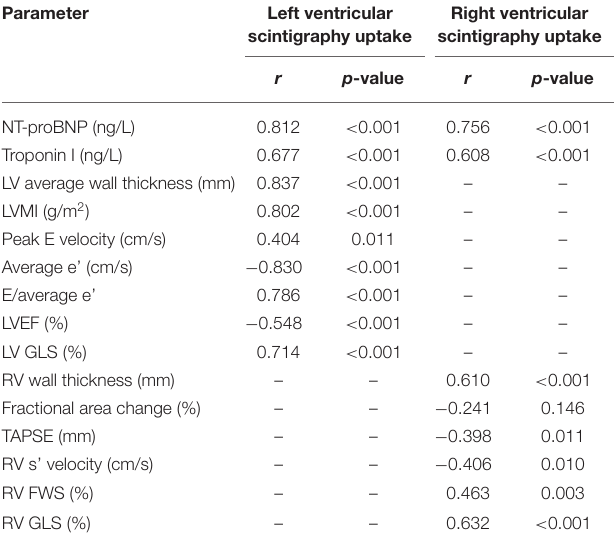
TABLE 2 | Correlation of clinical and echocardiographic parameters with 99m Tc-DPD tracer uptake in ATTR patients ( n = 40). Parameter Left ventricular Right ventricular scintigraphy uptake scintigraphy